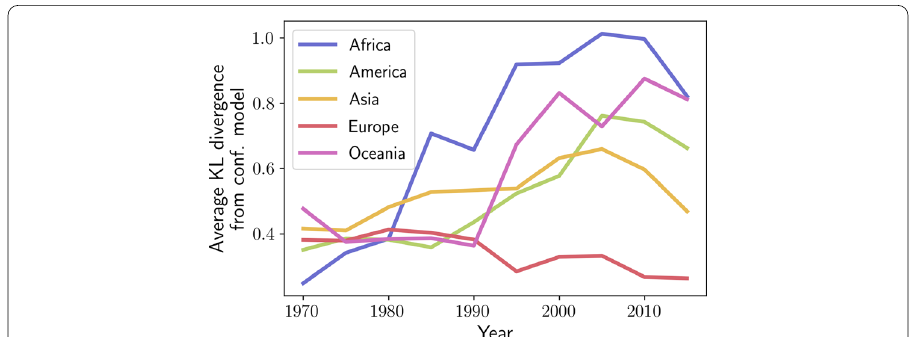
Fig. 7 Average KL divergence (as defined in Eq. (23)) for each continent between the observed collaboration counts and those expected by the configuration model. Over time, the configuration model has become a better description for Europe, while other continents have further